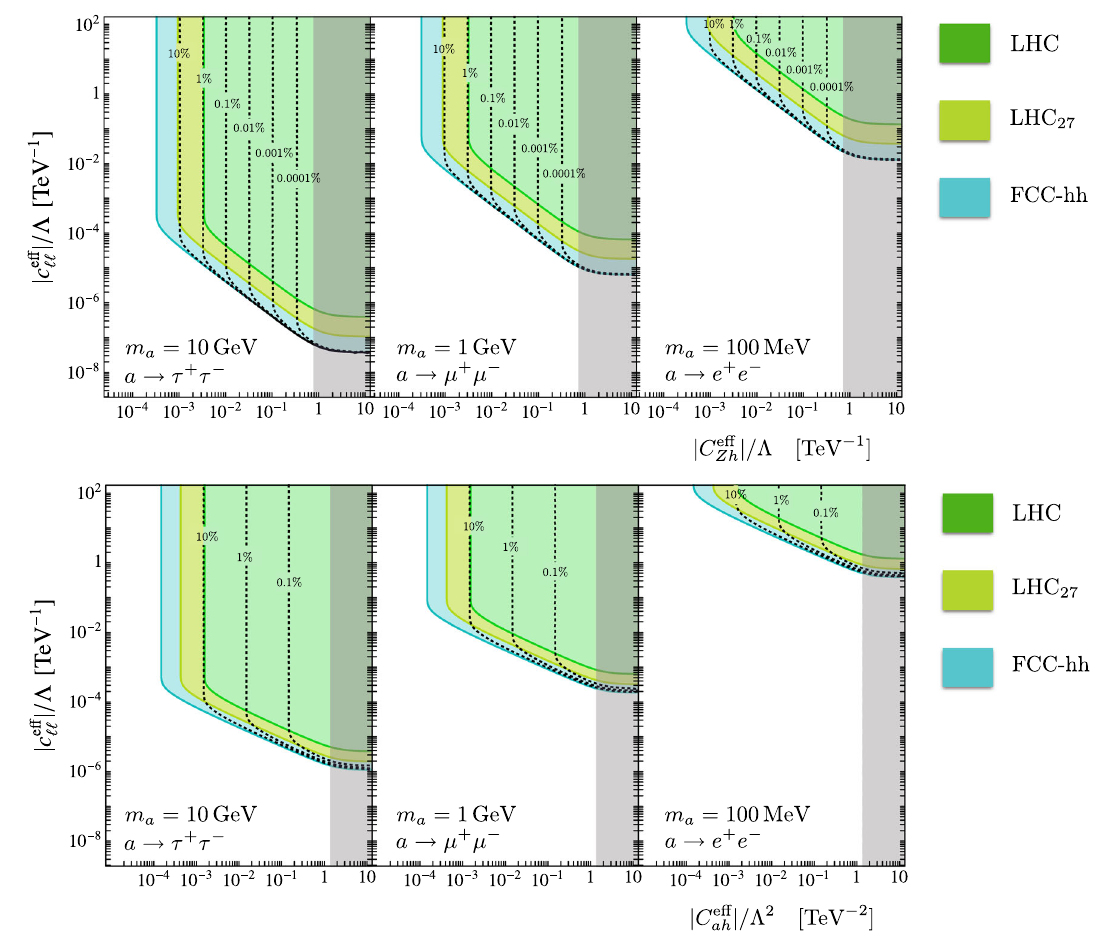
Fig. 16 Projected reach in searches for h → Za → (cid:10) + (cid:10) − + (cid:10) + (cid:10) − and h → aa → 4 (cid:10) decays with the LHC (green), HE-LHC (light green) and a 100TeV collider (blue). The parameter region with the solid con-